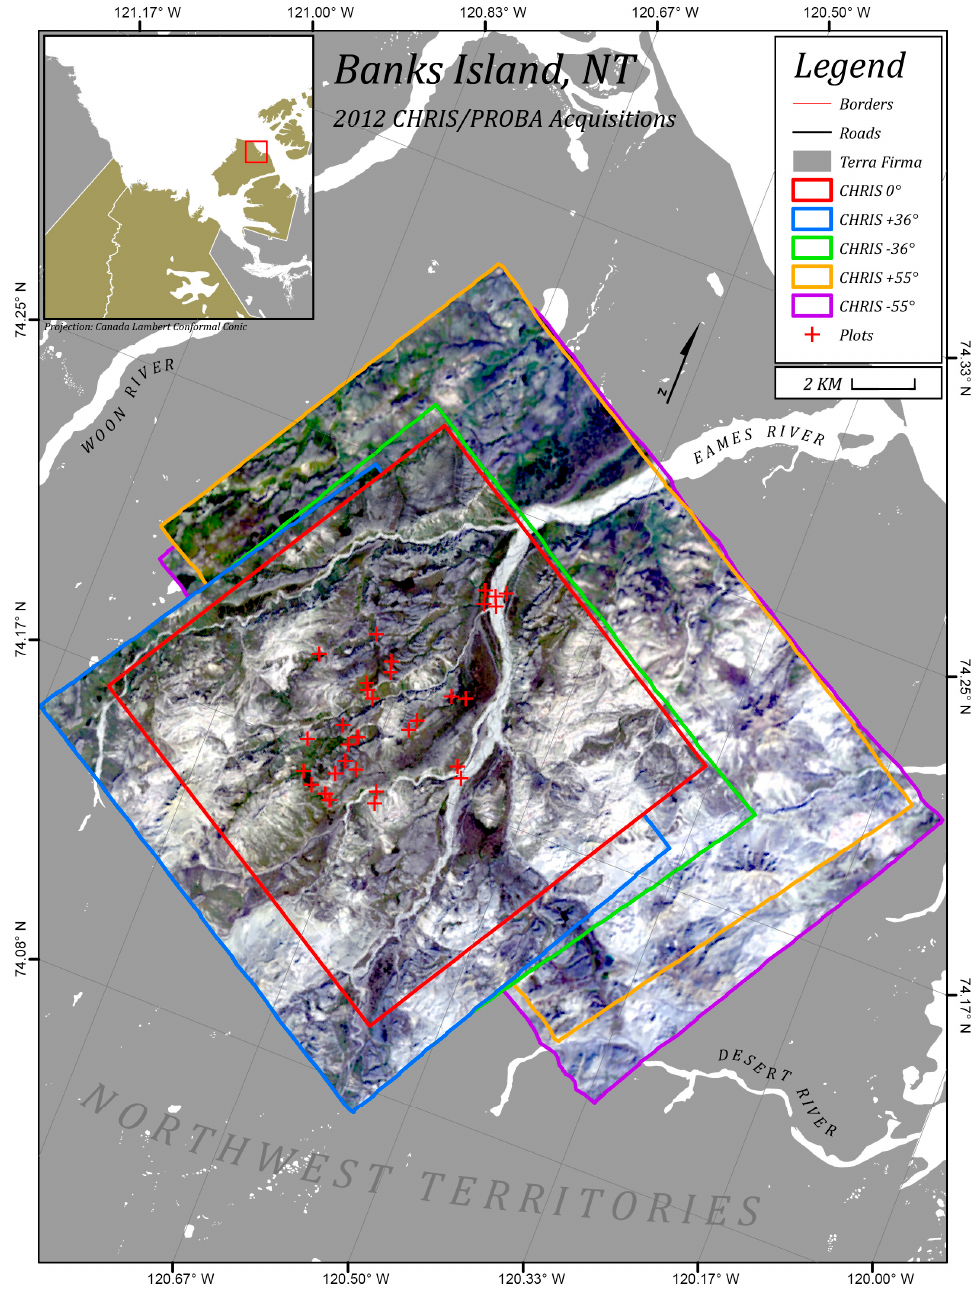
Figure 1. Multi-angle CHRIS Mode-1 (M1) acquisitions for Banks Island, Northwest Territories (NT) on 1 August 2012. The images are colour composites of bands 23 (red, 651 nm), 13 (green, 551 nm) and 3 (blue, 452 nm). Field plots (90 m × 90 m) are indicated with a red cross. Map created using Atlas of Canada National Scale Data 1:1,000,000 [82] and Northern Geodatabase [83]. Additional image pre-processing was conducted using the CHRIS/PROBA Toolbox software developed as an extension for the VISAT BEAM version 5.0 (Brockmann Consult, https://www.brockmann-consult.de/beam accessed on 7 April 2021). De-striping and noise reduction of raw imagery involved correction of dropouts in image rows, which is common in channel 2, and correction of vertical striping in image columns by interpolating from neighboring pixel values and spectral bands [84,85]. Cloud detection and masking was conducted using the algorithm developed by G ó mez-Chova et al. [86], which provides probability and cloud abundance for each pixel. Atmospheric correction was